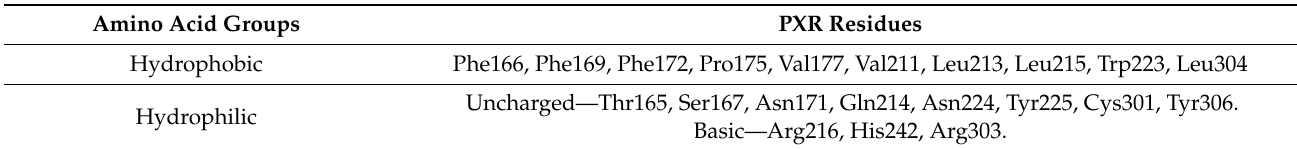
Table 3. Predicted residues in the PXR allosteric site